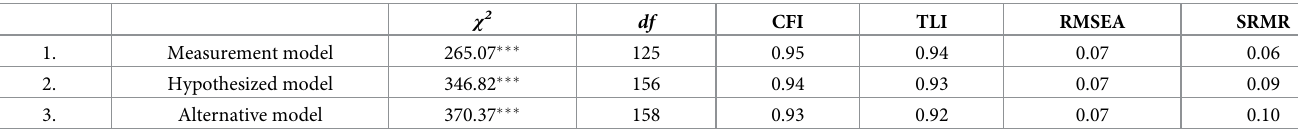
Table 1. Results of fit statistics for measurement, hypothesized, and alternative